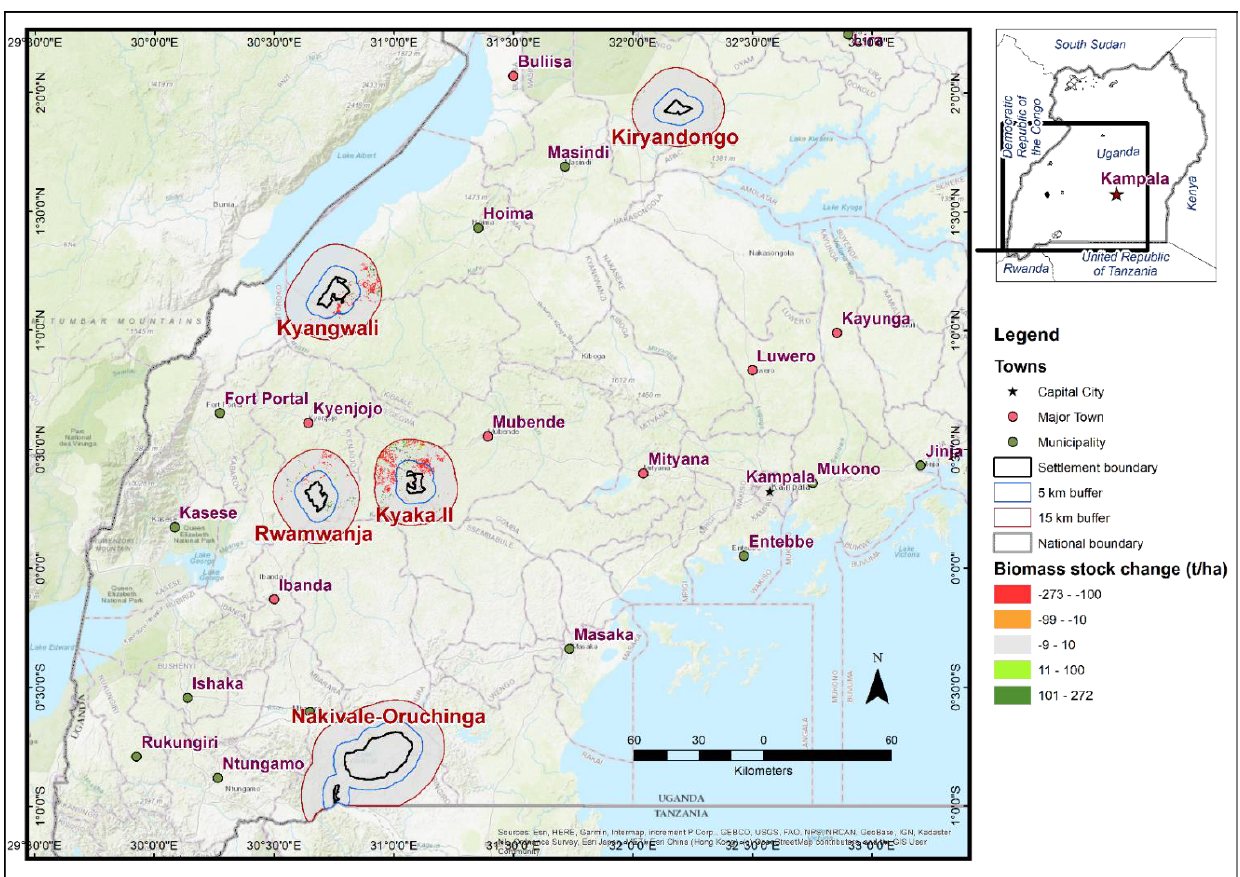
Figure 7. Biomass stock changes between 2000 and 2017 within the AoI in western and southwestern Uganda. Source: World Bank and FAO, 2020b [30].